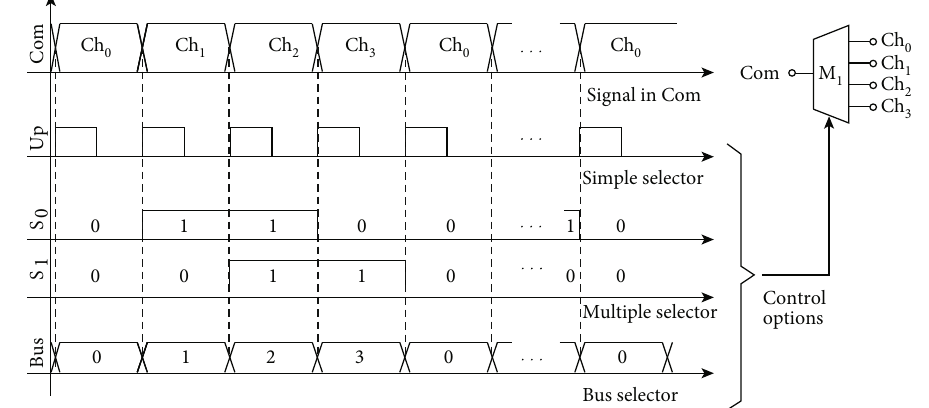
Figure 12: Types of selection